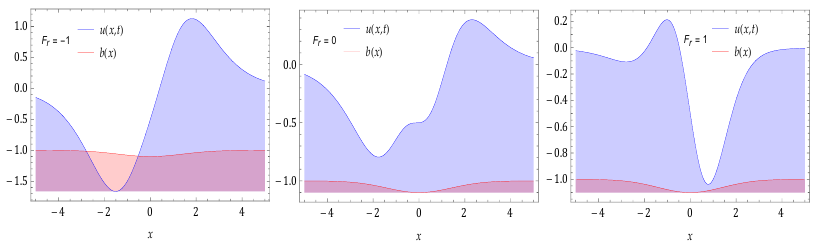
Figure 4. Nature of water elevation with b ( x ) at n = 1 , (cid:125) = − 1 , β = 2 , t = 1 . 5 and α = 1.